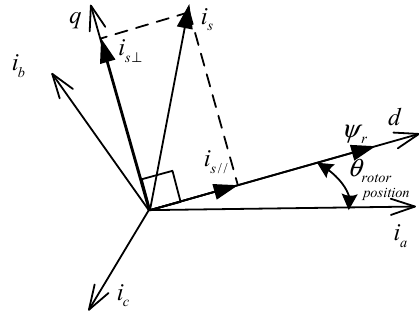
Figure 1. Vector diagram about current decomposition based on initial rotor position.